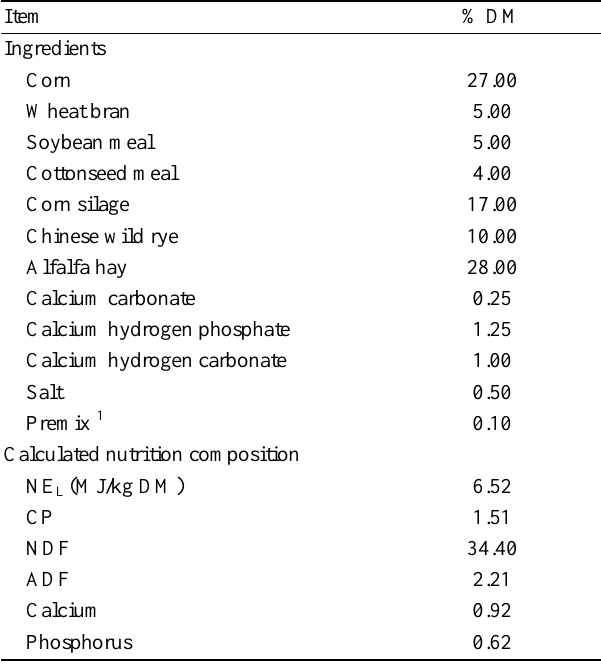
Table 2. Diet ingredients and chemical composition for the rumen fistulated